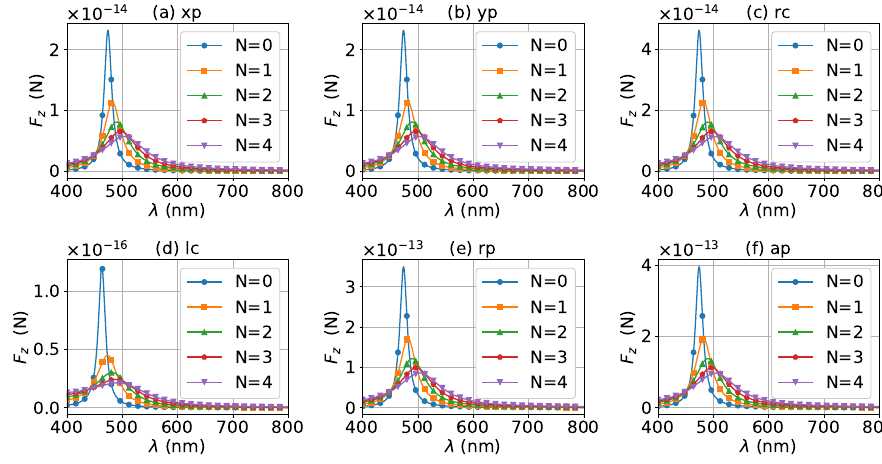
Figure 16. The same as in Figure 15, but with α 0 = 20 ◦ .